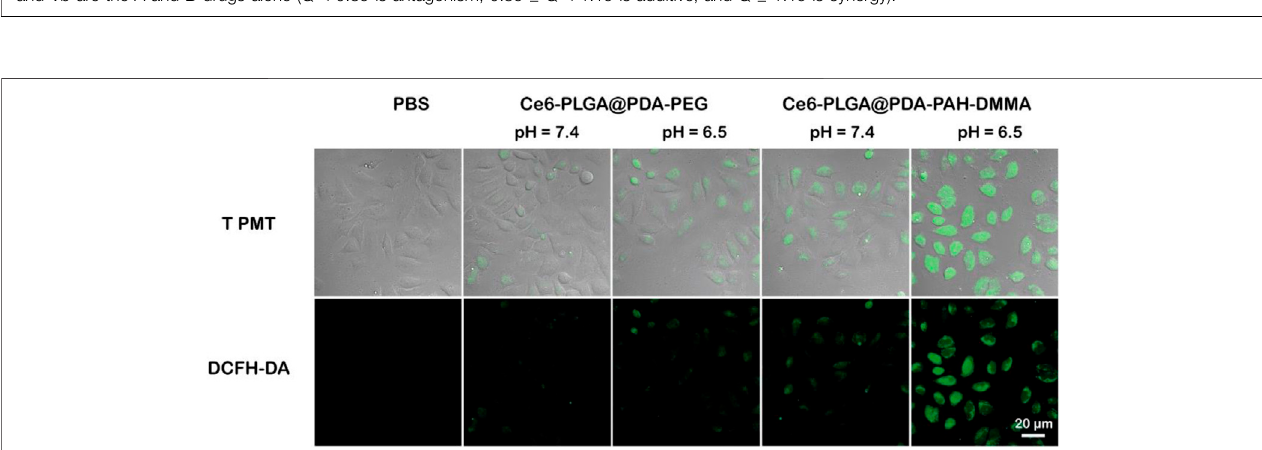
FIGURE 6 | Confocal images of ROS generation by cells treated with PBS (control), Ce6-PLGA@PDA-PEG NPs, and Ce6-PLGA@PDA-PAH-DMMA NPs.